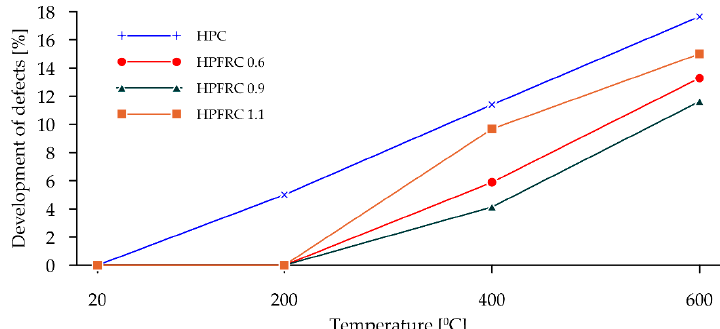
Figure 17. Defects